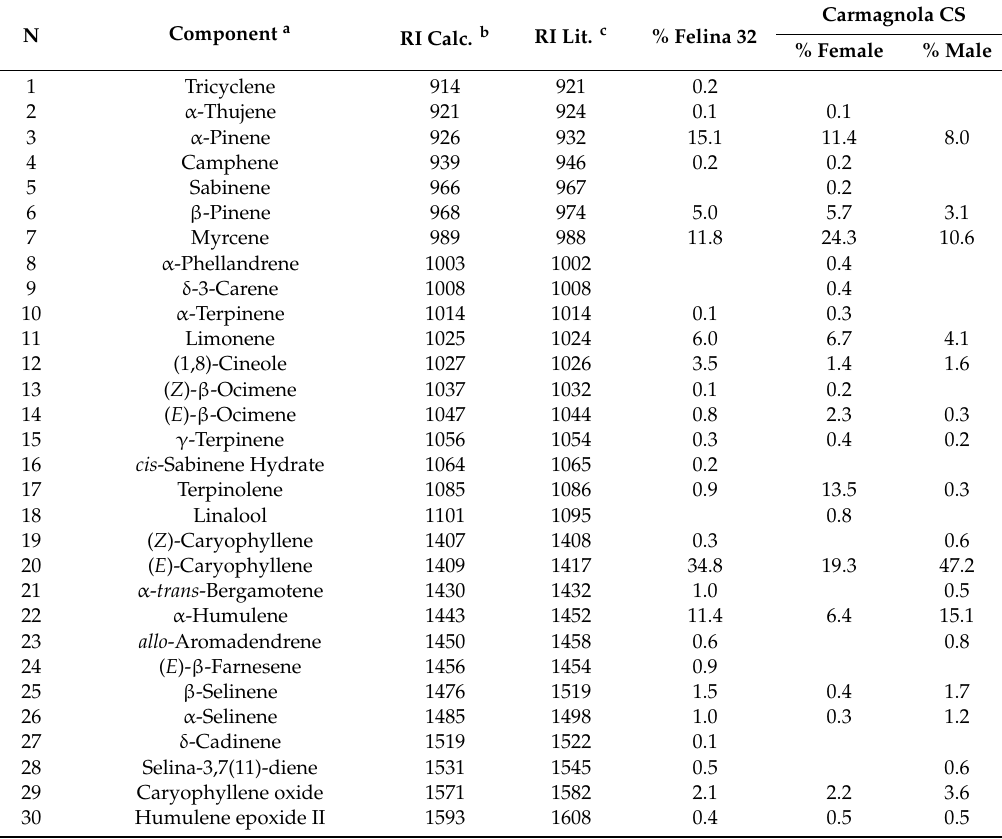
Table 1. Chemical characterization of the hemp essential oils obtained from monoecious, male, and female inflorescences of hemp, cv Felina 32 and Carmagnola Selezionata (CS). N Component a RI Calc. b RI Lit. c